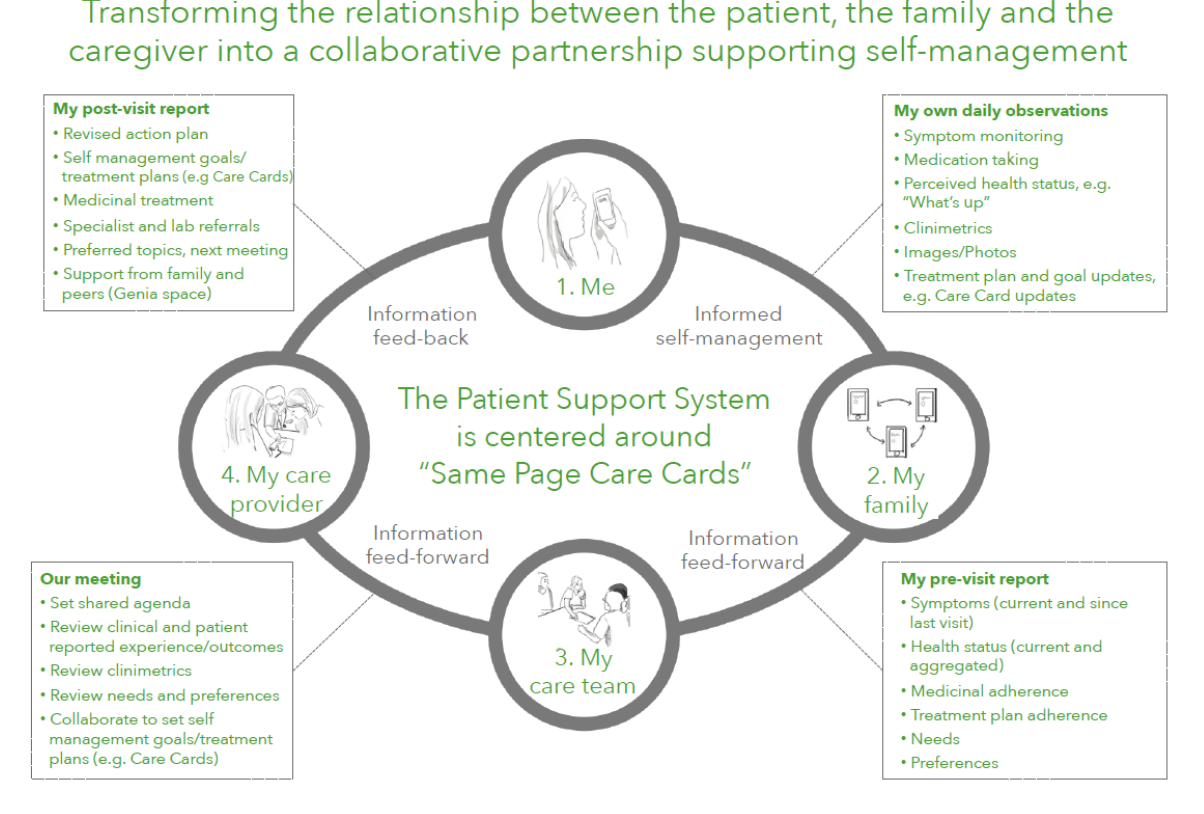
Figure 1. Genia flow